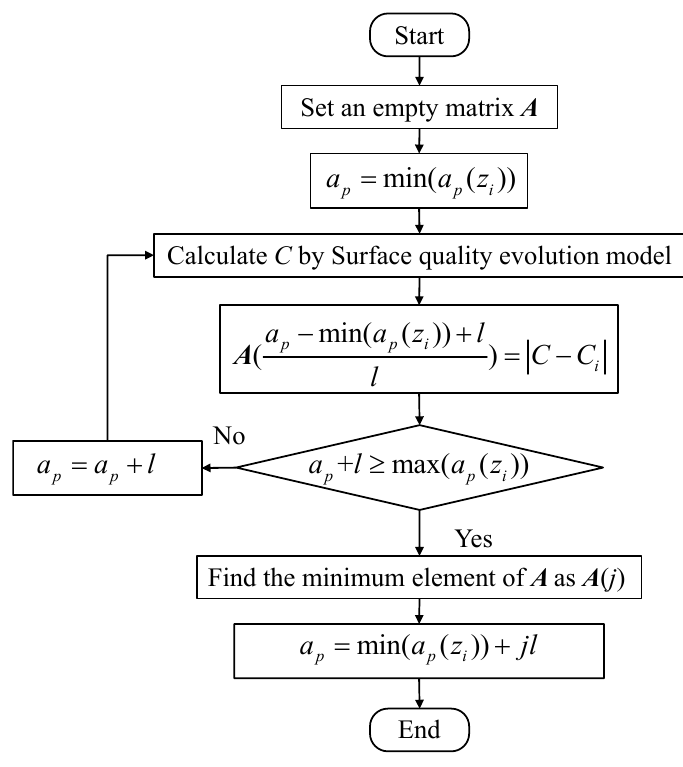
Figure 12. The process of obtaining the desired comprehensive index C i for point z i .